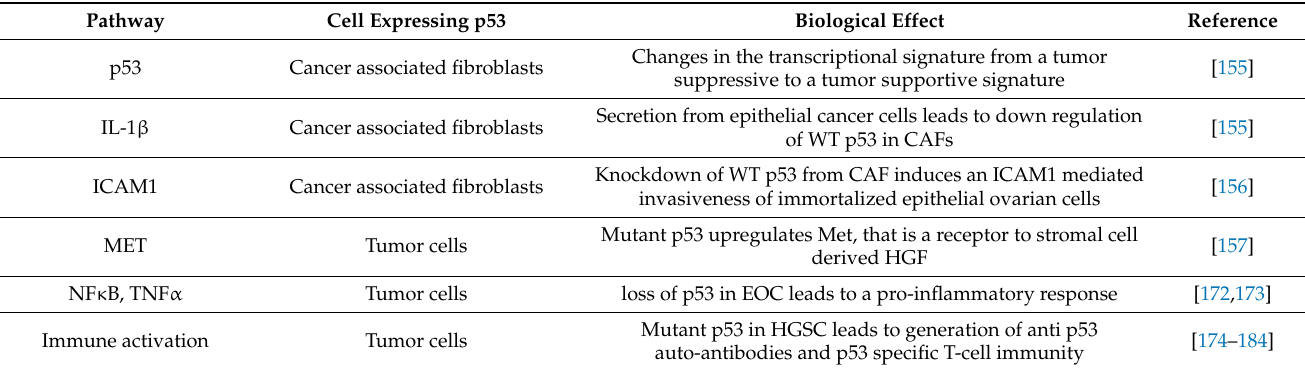
Table 3. The role of p53 in the